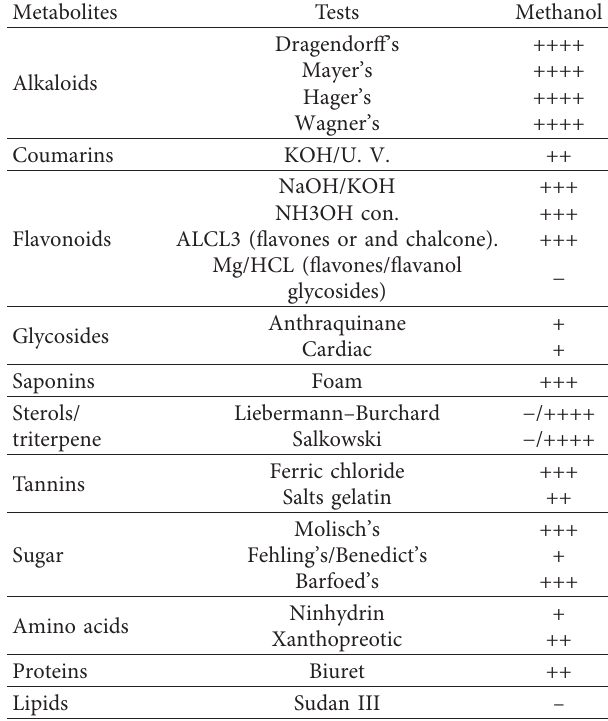
Table 2: Results of phytochemical screening of Senna occidentalis